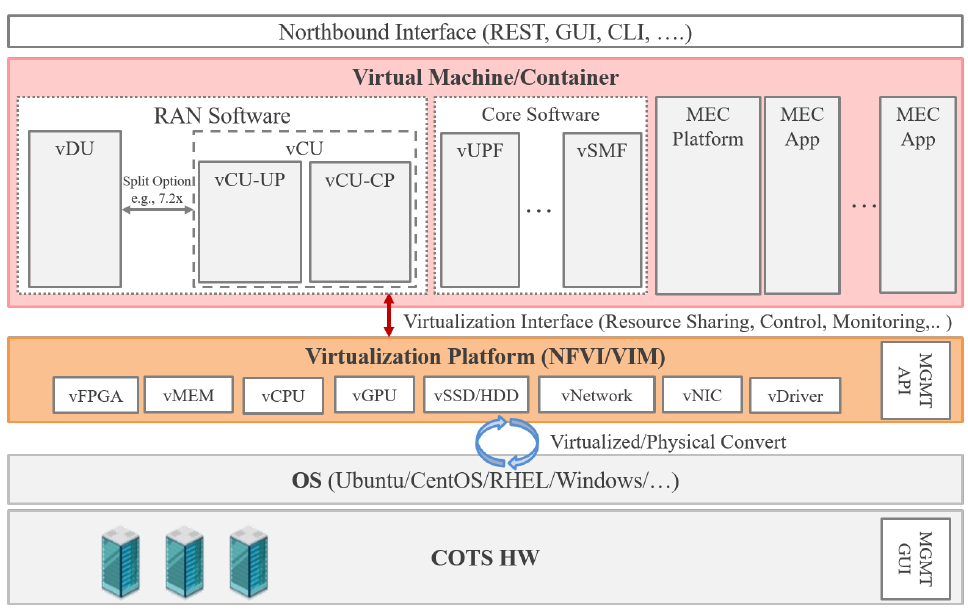
Figure 11. Edge Platform. Table 3. Throughput performance in PoC Field employing MEC.